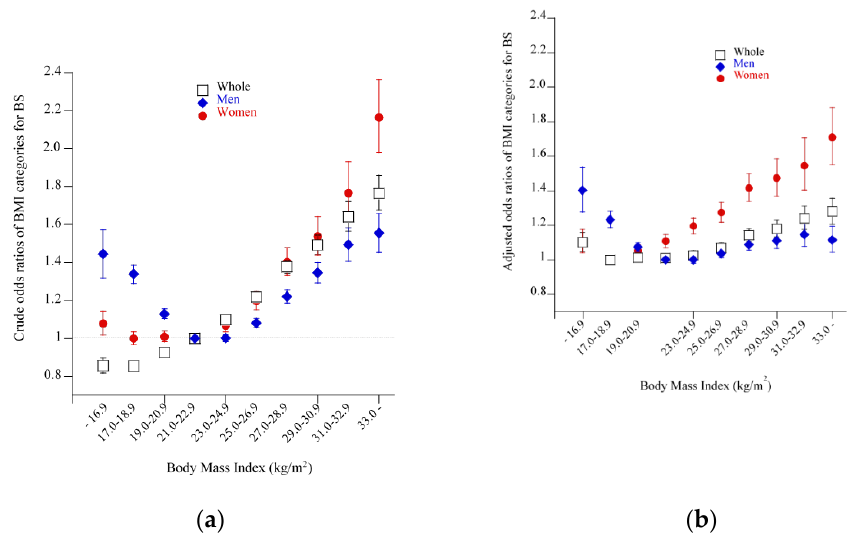
Figure 4. Odds ratios and 95% confidence intervals of BMI categories for breakfast skipping (BS). ( a ) Crude odds ratios and 95% confidence intervals for all subjects and for men and women separately. ( b ) Odds ratios and 95% confidence intervals for men and women after adjustment for age, smoking, pharmacotherapy for hypertension, pharmacotherapy for dyslipidemia, history of cardiovascular disease, moderate to heavy consumption of alcohol (≥46 g ethanol per day), habitual exercise, LND, LNS, and sex (in the case of all subjects). The symbols and bars express odds ratios and 95% confidence intervals. BS: Breakfast skipping, LND: Late-night dinner, LNS: Late-night snack.